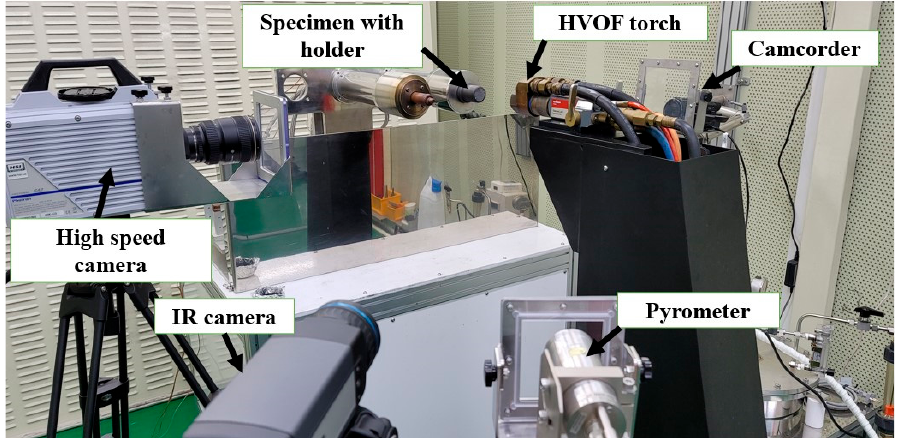
Figure 5. Experimental setup photograph. A two-color pyrometer (IMPAC series ISQ 5 model from LumaSense Technologies, Santa Clara, CA, USA with a measurement range from 1073.15 K to 3073.15 K) was used to measure the specimen stagnation point temperatures during the tests. An infrared (IR) camera (FLIR A655SC, theoretically, can measure up to 2273.15 K and measurements higher than 2273.15 K are also possible under certain conditions) was used to capture IR images of the specimen flow-facing surfaces during the tests. From IR camera images, specimen stagnation point temperatures were estimated and compared with the pyrome- ter data. The IR camera emissivity was set arbitrarily during the tests and later, during data analysis, the emissivity values were adjusted, until the IR camera temperature data matched with the pyrometer values. A camcorder and a high-speed camera were used to observe and record the specimen reactions during the tests.